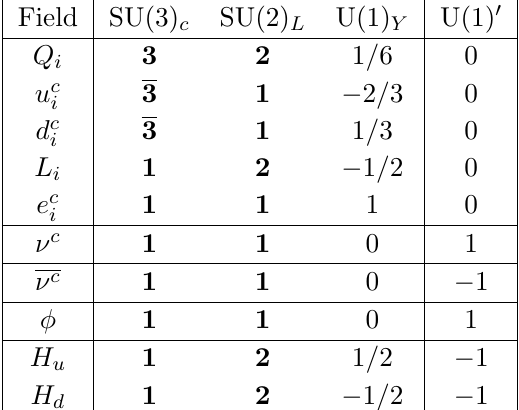
Table 1 . The minimal model consists of three left-handed families gated right-handed (cid:12)elds c